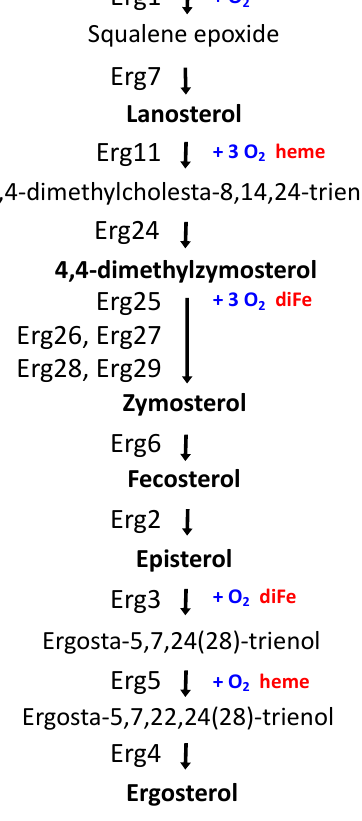
Figure 1. Late S. cerevisiae ergosterol biosynthetic pathway. Erg1: squalene monooxygenase. Erg7: lanosterol synthase. Erg11: lanosterol C-14 demethylase. Erg24: sterol C-14 reductase. Erg25: sterol C-4 methyloxydase. Erg26: sterol C-3 dehydrogenase. Erg27: sterol C-3 ketoreductase. Erg28 and Erg29: C-4 demethylation complex reaction. Erg6: sterol C-24 methyltransferase. Erg2: sterol C-8 isomerase. Erg3: sterol C-5 desaturase. Erg5: sterol C-22 desaturase. Erg4: sterol C-24 reductase. Sterol intermediates, enzymes, and their requirements of oxygen and iron are shown.